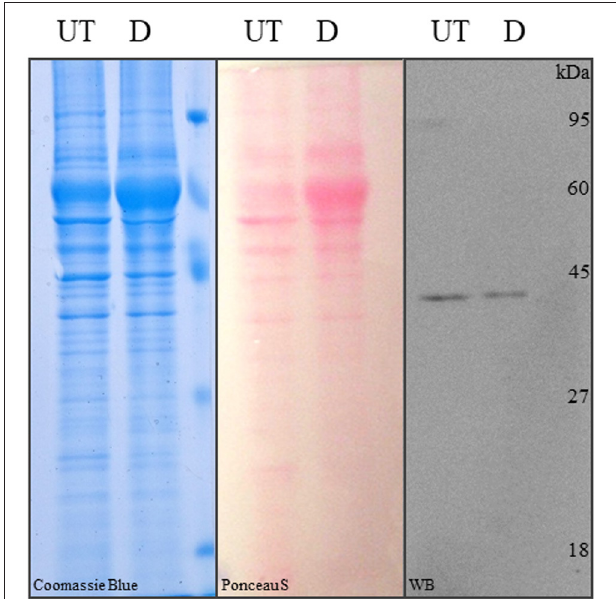
FIGURE 5 | SDS-PAGE and Western blot analysis of differentiated and control hASCs. Proteins from whole cell lysates of untreated (UT) or differentiated (D) hASCs were solved in 12% acrylamide gels and stained with Coomasie blue (left image). The proteins were transferred to PVDF membranes from an unstained 12% acrylamide gel and stained with Ponceau S (central image). Immune anti- β -actin detection in hASCs whole cell lysates. 10 µ g of whole cell lysate were loaded/lane. A representative image from three experiments is